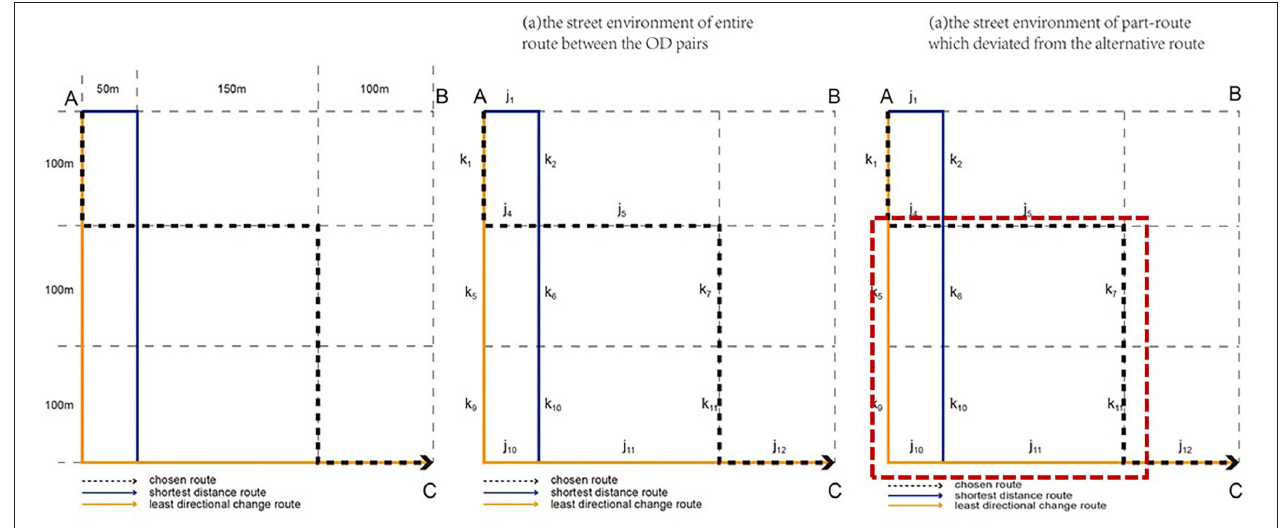
FIGURE 3 | The two forms of the route adjustment process.